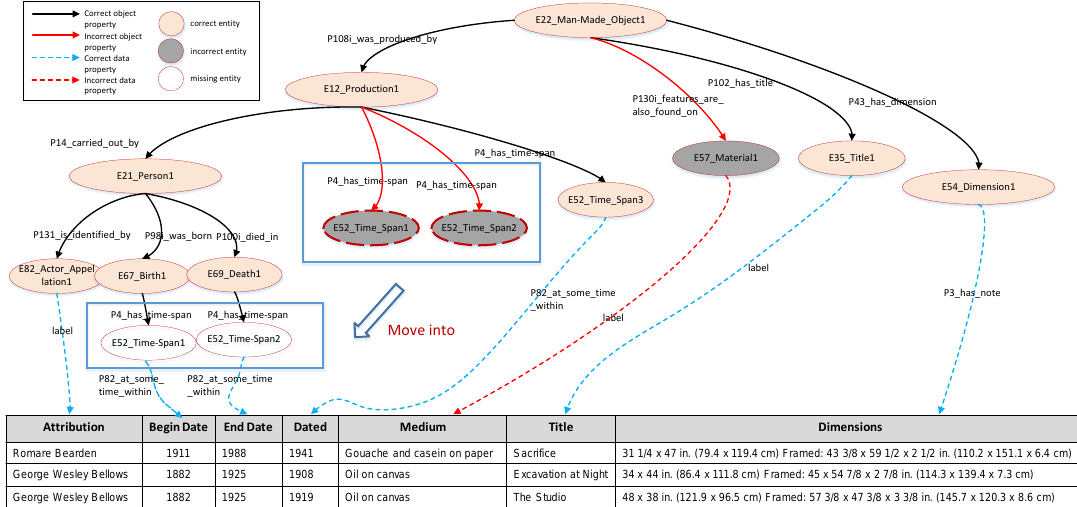
Figure 4. The change of seed model of CB after moving ambiguous